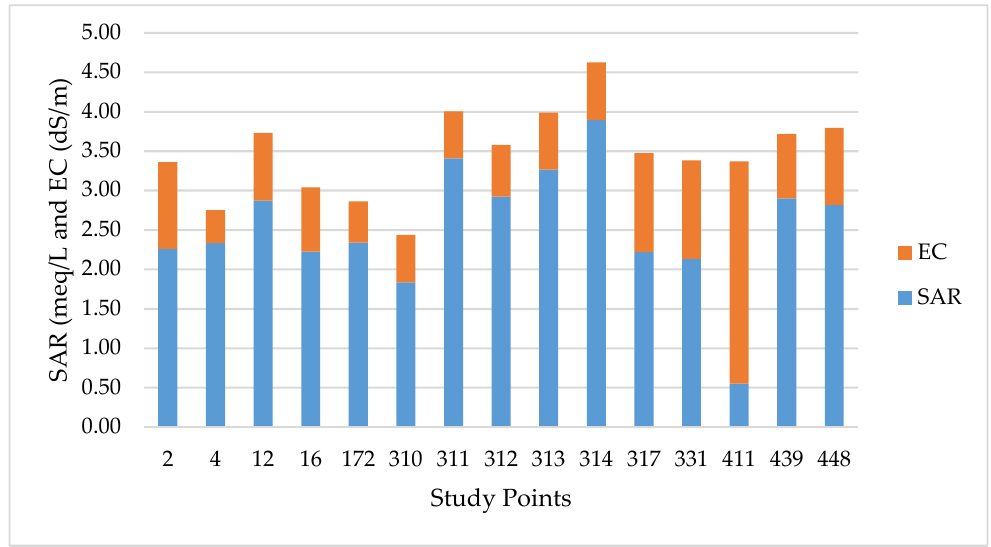
Figure 7. Infiltration rate issues using SAR and EC.